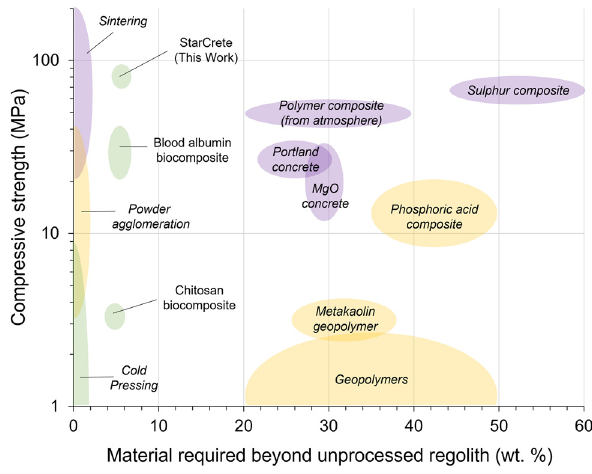
Figure 1: Comparison of proposed ISRU technologies for the stabi - lisation of extraterrestrial regolith into solid materials. Ultimate compressive strength ( UCS ) range of materials plotted against the proportion of material required beyond unprocessed regolith. Purple, yellow and green colours indicate high - , medium - and low - energy processes, respectively. Figure adapted from Karl et al. [ 9 ]